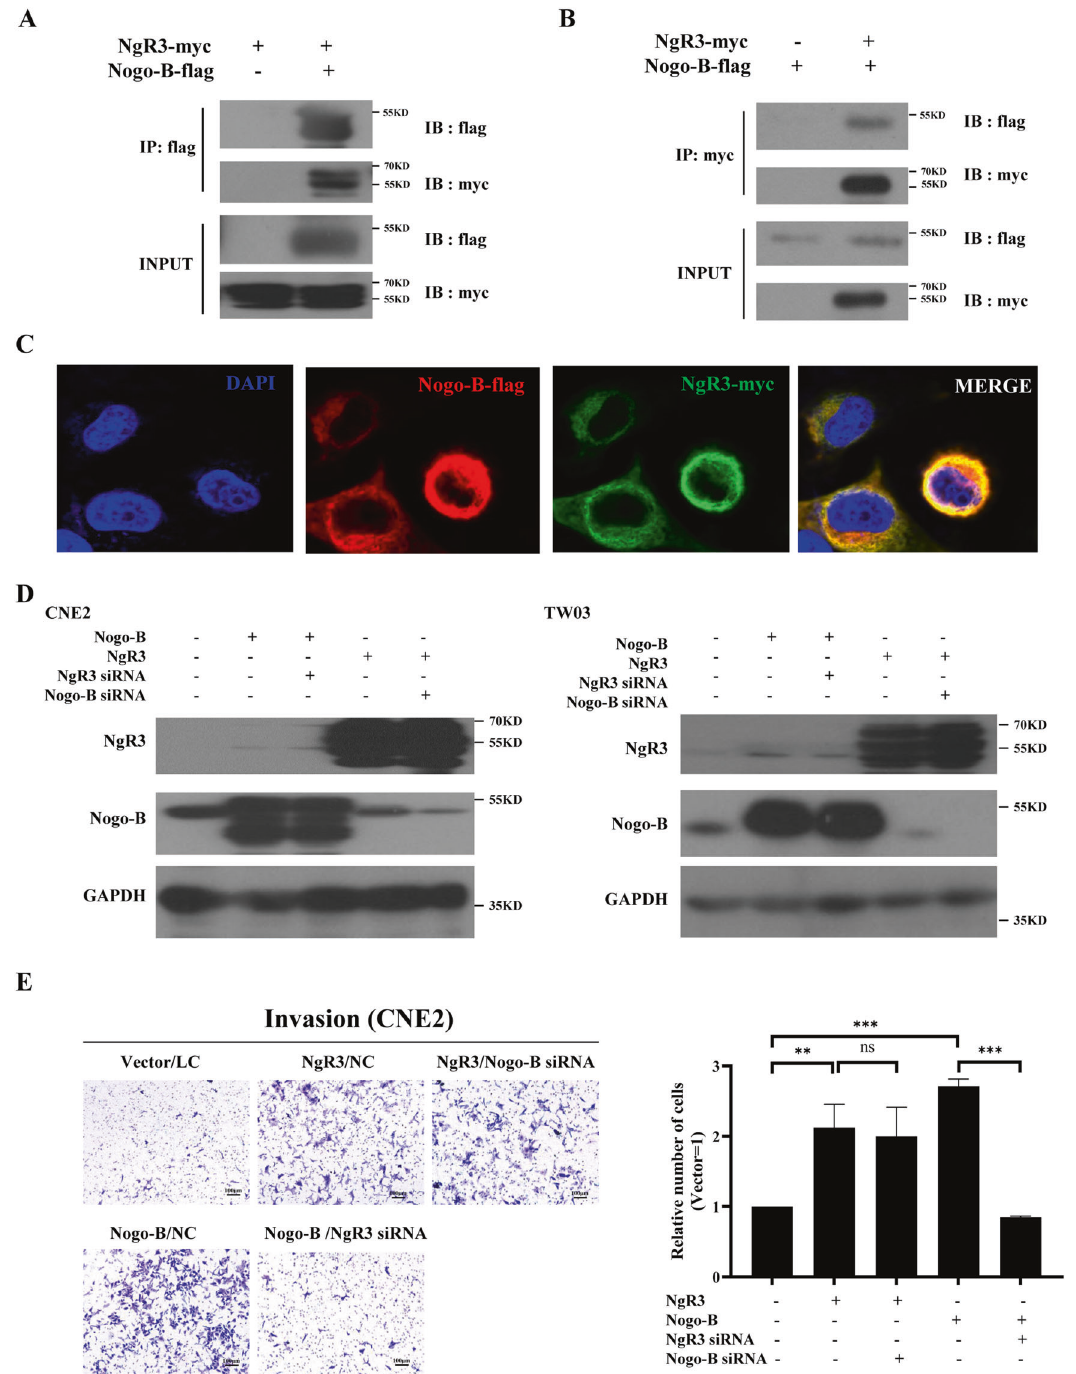
Fig. 4 Nogo-B regulates NPC cell migration through NgR3. A Lysates from HEK293T cells transfected with NgR3-myc and Nogo-B- fl ag were subjected to immunoprecipitation using beads with anti- fl ag antibody, and coimmunoprecipitated NgR3-myc was detected by Western blotting. The total protein expression levels were con fi rmed. B Lysates from HEK293T cells transfected with NgR3-myc and Nogo-B- fl ag were subjected to immunoprecipitation using beads with anti-myc antibody, and coimmunoprecipitated Nogo-B- fl ag was detected by Western blotting. The total protein expression levels were con fi rmed. C CNE2 cells were transfected with NgR3-myc and Nogo-B- fl ag. Immuno fl uorescence showed that NgR3 and Nogo-B were colocalized. D NgR3 siRNA or Nogo-B siRNA could not in fl uence each other ’ s protein expression. E The average number of invaded CNE2 cells in three fi elds decreased by NgR3 siRNA even when Nogo-B was overexpressed. stage and M stage in NPC patients, suggesting that Nogo-B should insuf fi cient to evaluate the OS, PFS, and DFS. Notably, Nogo-B may play a more crucial role in invasion and distant metastasis than that be a prognostic marker of NPC complementary to the TNM stage in tumorigenesis of NPC. Therefore, in our study, we focused on the system. Though expression of Nogo-B was not related to T stage of role of Nogo-B on the migration, invasion, and metastasis in NPC. patients, high expression of Nogo-B was mainly associated with N Cell Death and Disease (2022)